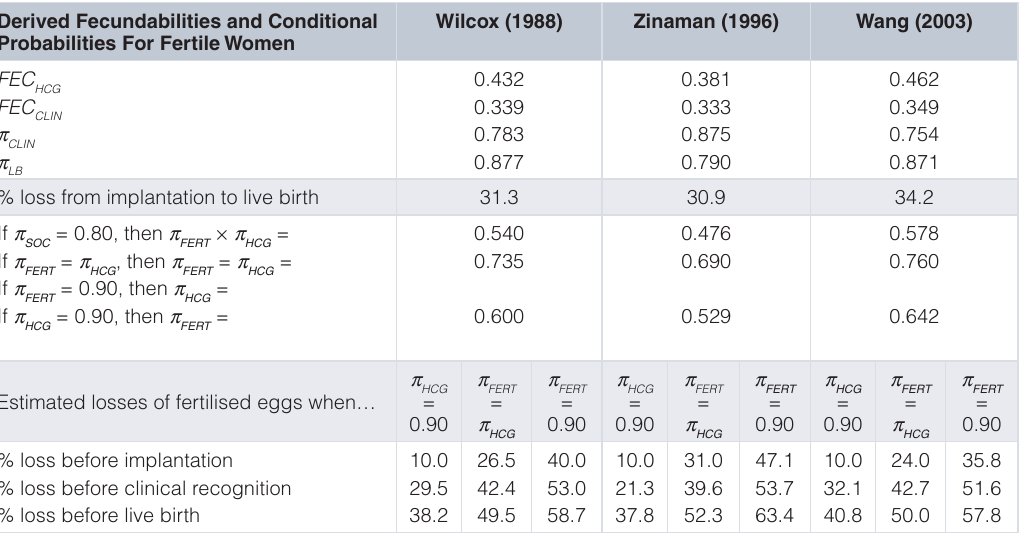
) and clinical ( FEC ) fecundabilities and π are HCG CLIN CLIN is calculated from published values in LB = 90%); (ii) equal HCG = π ); (iii) high fertilisation probability ( π = 90%). The probability FERT HCG FERT ) was assumed to be SOC